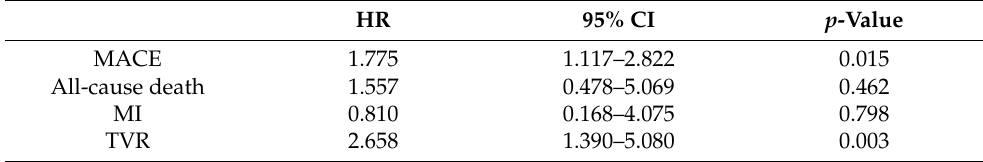
Table 3. Prognostic value of MS